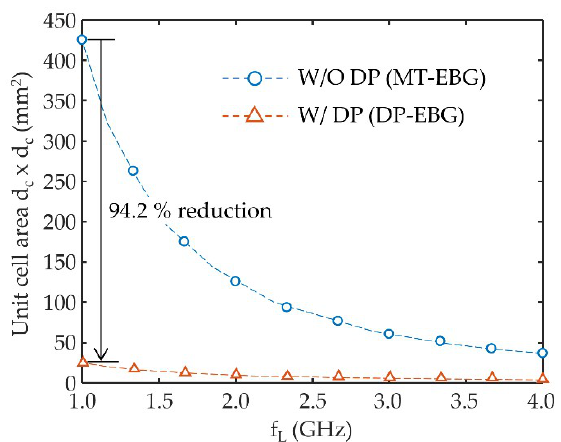
Figure 8. Comparison of unit-cell miniaturization between previous MT– and proposed DP–EBG structures.